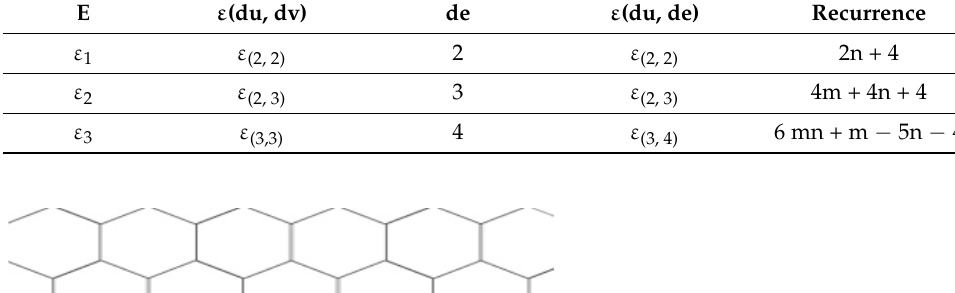
Table 6. Edge partition of regular hexagonal cells network.